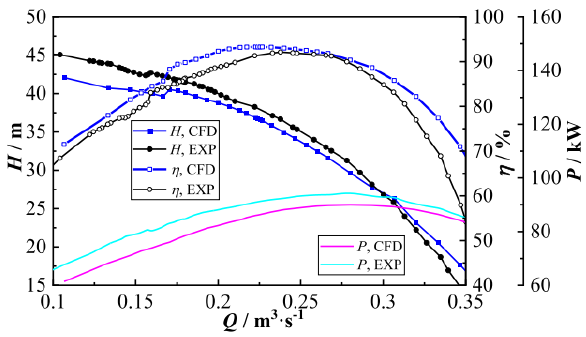
Figure 24. Characteristics of the pump